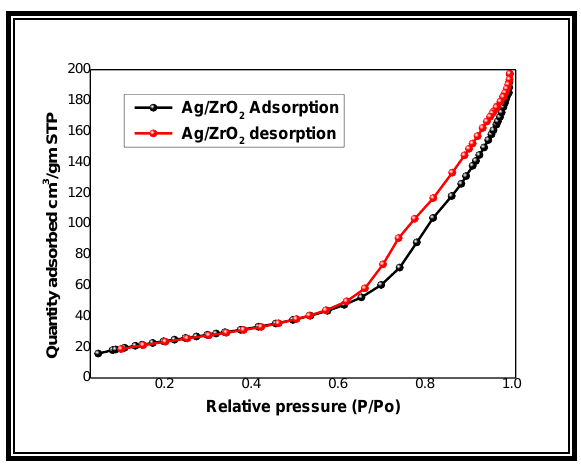
Figure 4. N 2 adsorption – desorption isotherms of 2.5% Ag 2 O – ZrO 2 catalyst.